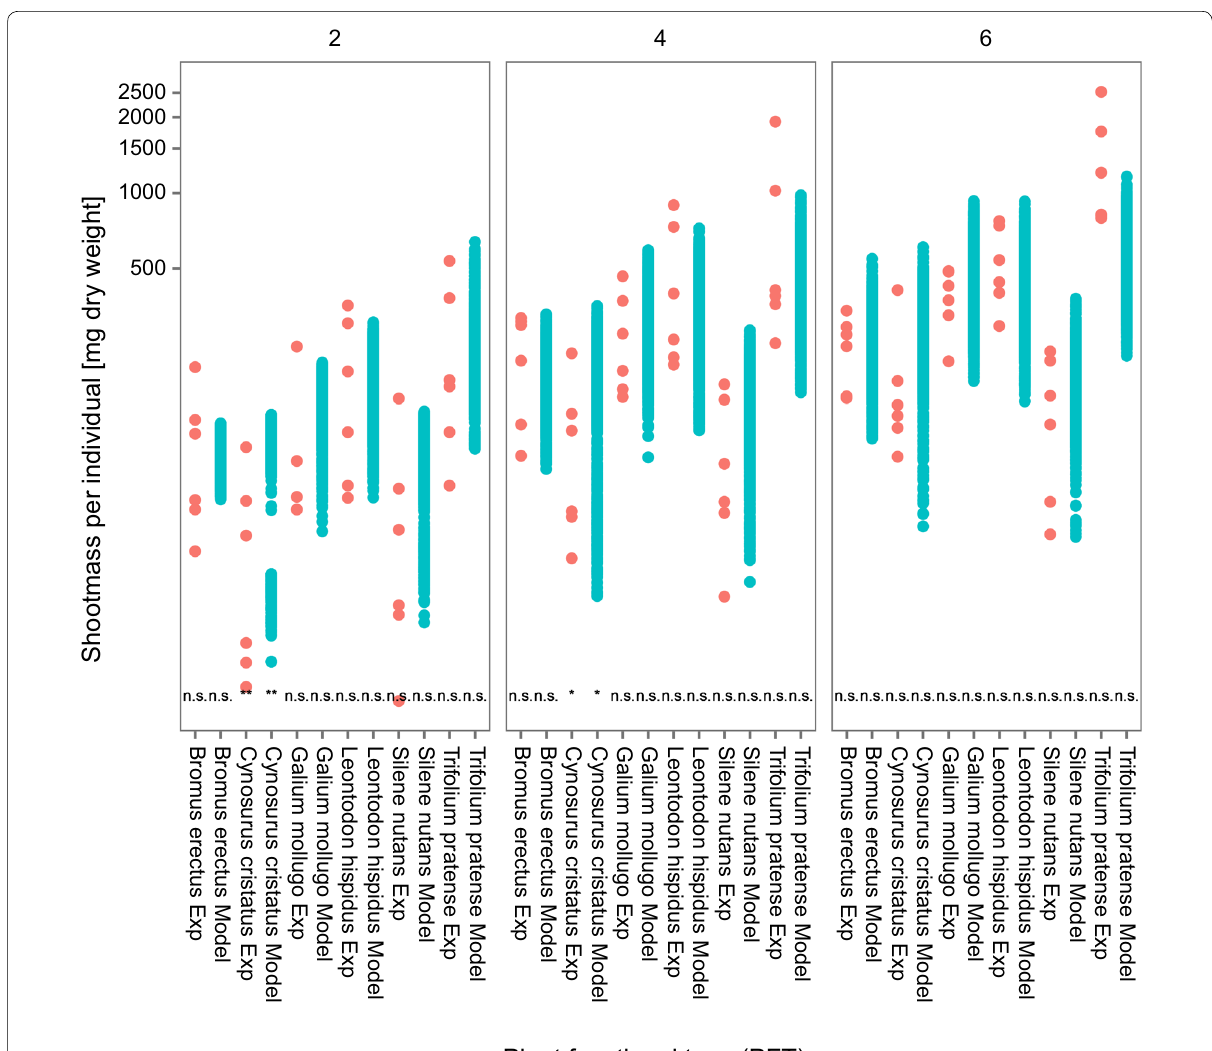
Fig. 4 Prediction of shoot growth in control community: Comparing the shoot weight of experimentally measured (red points, N (blue points, N 900 covering potential variability in resource levels) data for each assessment date in control communities. Experimental values = measured in fresh weight were converted to dry weight using a conversion factor based on a repeated monoculture control experiment, in which we measured the fresh to dry weight ratio of each species. Both broad spectrum herbicide and selective herbicide control values are included in the experimental data. Each experiment-model pair was tested for significance using a t -test; not significant results indicate that there are no differences between experimental and model data. Please note the logarithmic scale of the y